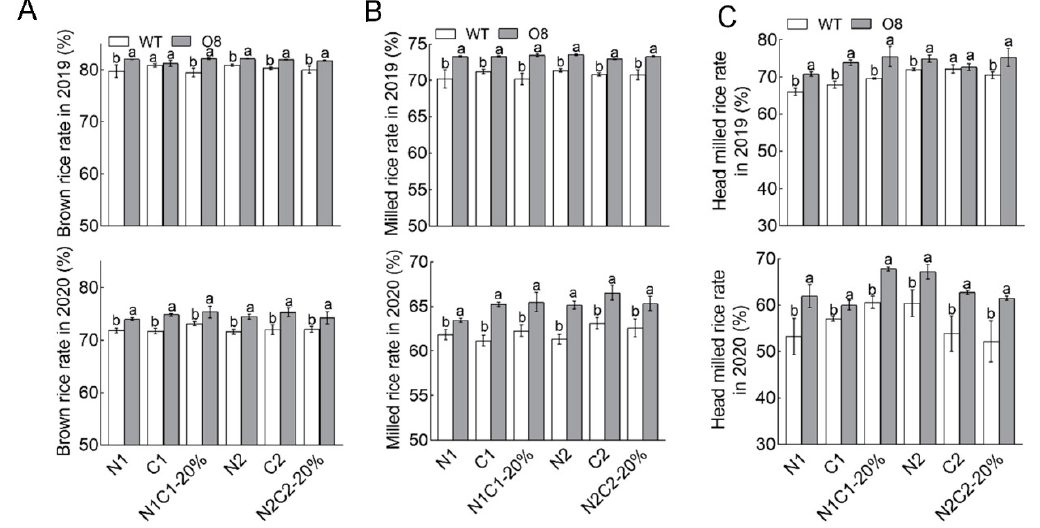
Figure 2. Milling quality trait of overexpress ion OsNRT2.3b line and wild type. Brown rice rate in two years, 2019 and 2020 ( A ), milled rice rate in two years, 2019 and 2020 ( B ), and head milled rice rate in two years, 2019 and 2020 ( C ) of overexpression OsNRT2.3b line (O8) and wild type (WT) under different fertiliser treatment conditions. N1: treatment with 90 kg/ha nitrogen fertilizer. C1: treatment with 90 kg/ha carbon fertilizer. N1C1-20%: 20% carbon fertilizer instead of nitrogen fertilizer (90 kg/ha). N2: treatment with 270 kg/ha nitrogen fertilizer; C2: treatment with 270 kg/ha carbon fertilizer. N2C2-20%: 20% carbon fertilizer instead of nitrogen fertilizer (270 kg/ha). Significant differences between O8 and WT are indicated by different letters ( p < 0.05). Table 2. Correlation analysis of different fertilizer treatments on quality of O8 and WT. Year Factors